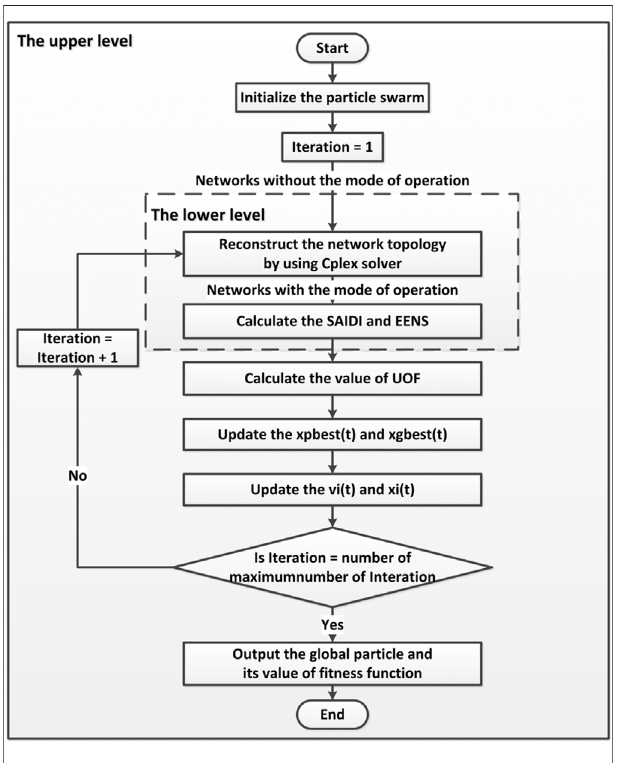
FIGURE 4 | Bus 2 of the Roy Billinton test